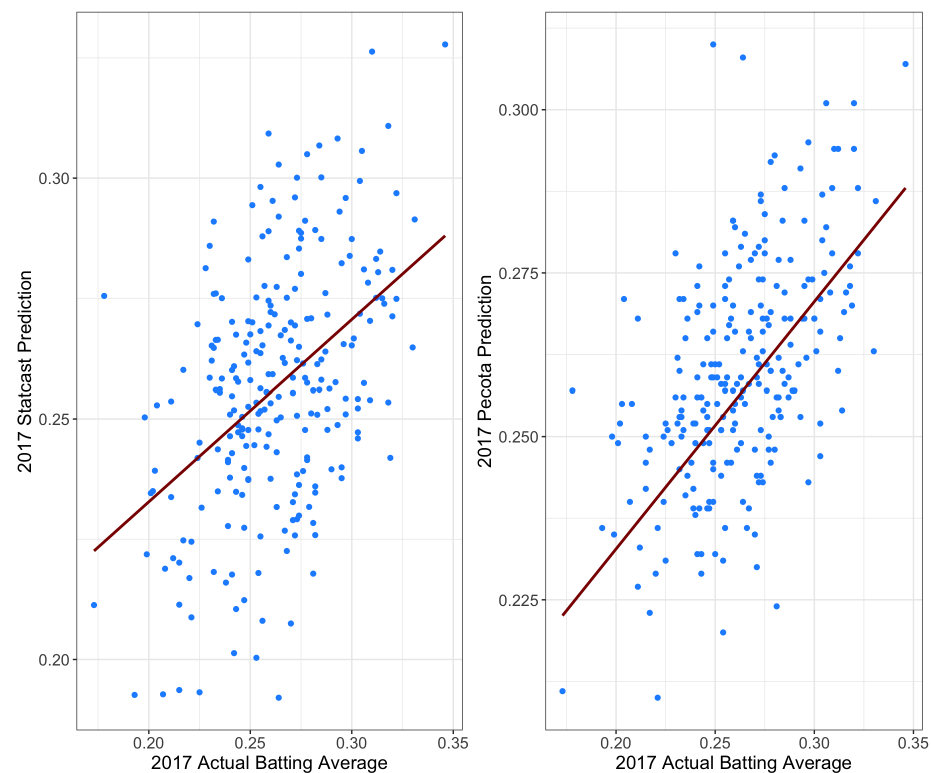
Figure 3. Scatterplots of the Statcast and PECOTA predictions for the 2017 season plotted against actual batting averages. Simple linear regression lines have been added to both